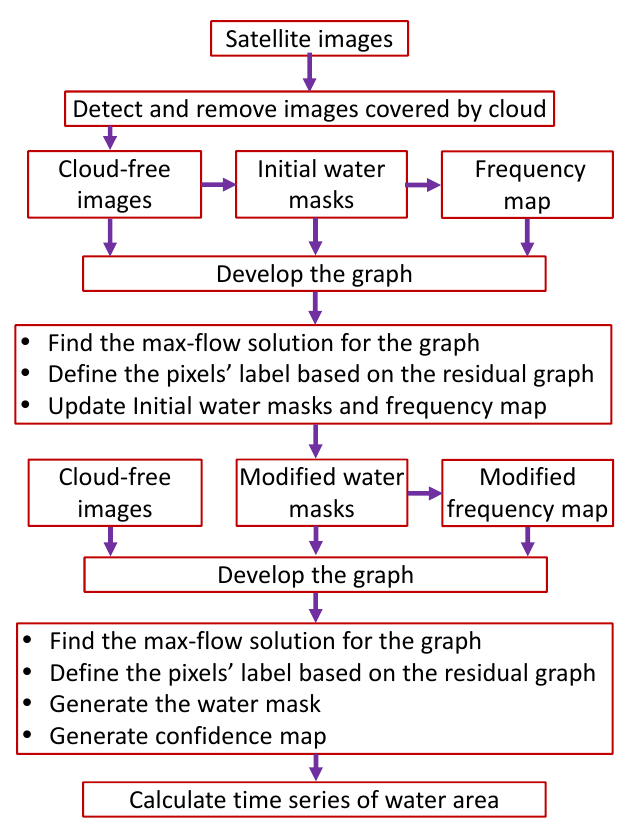
Figure 11. Flowchart for the proposed